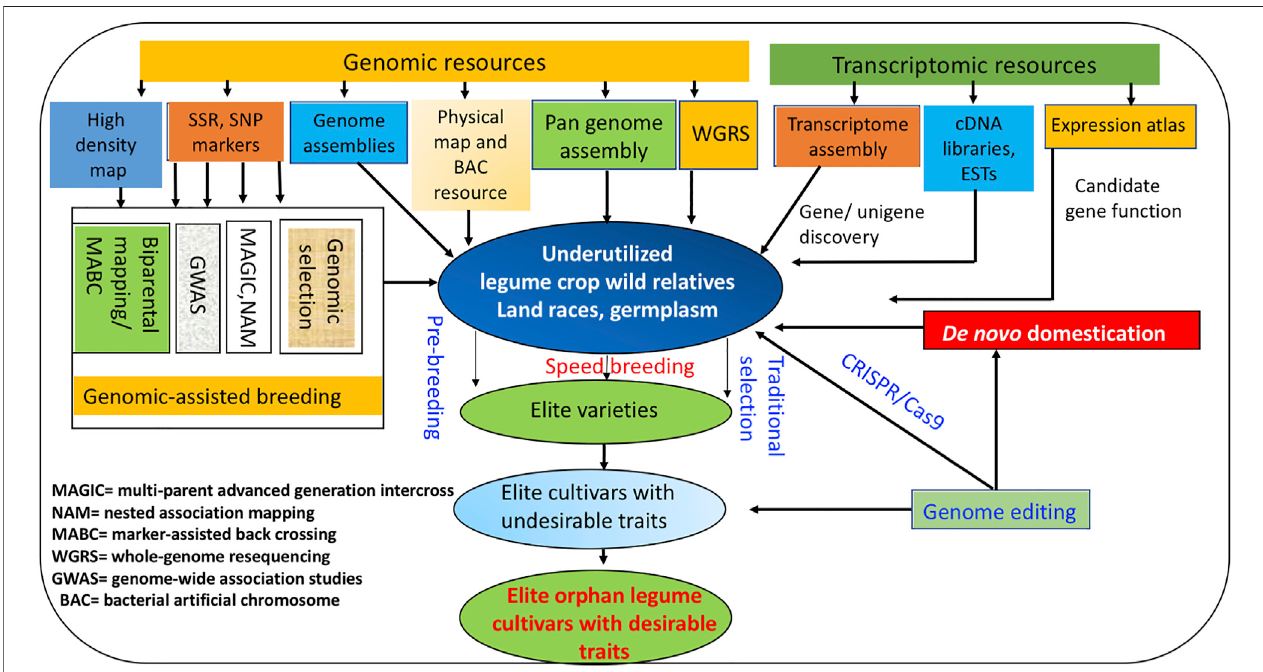
FIGURE 1 | “ Omics ” and emerging novel breeding approaches for improving genetic gain in underutilized legumes.